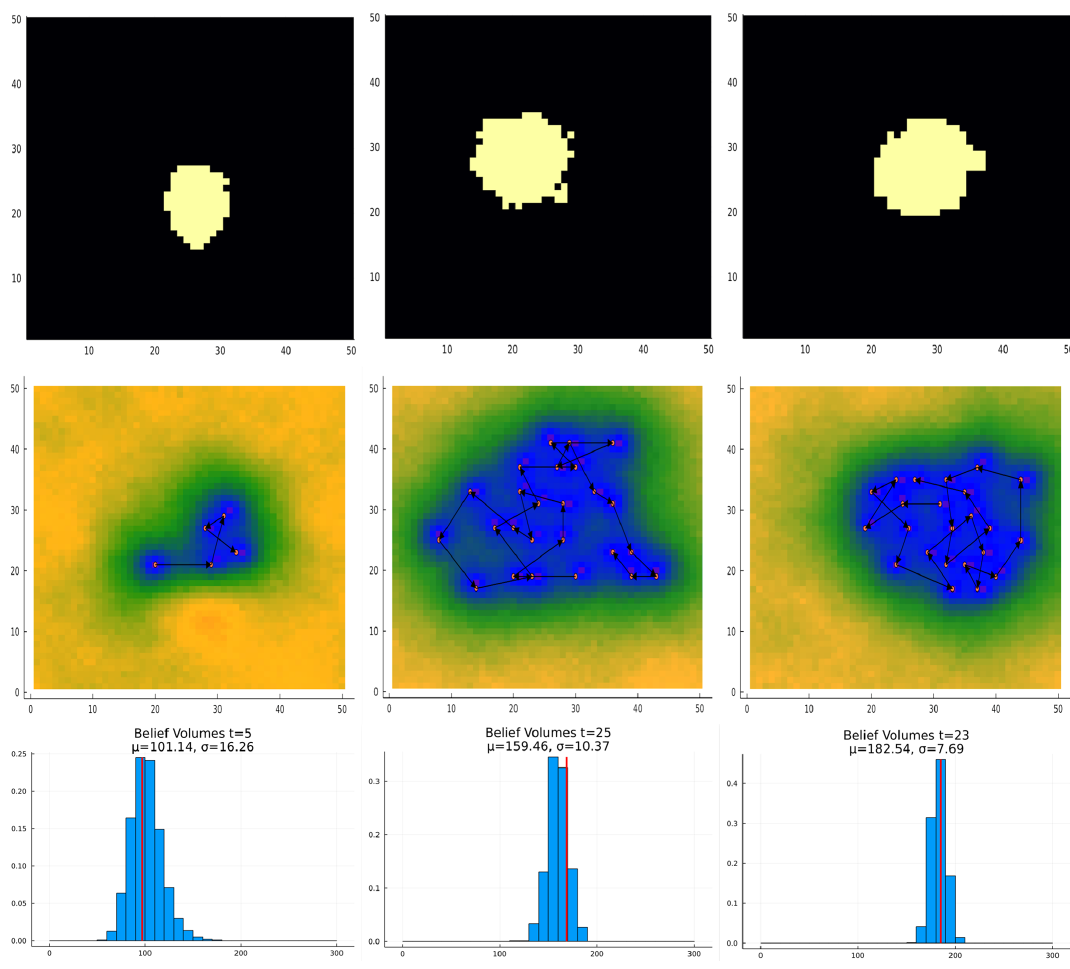
Figure 30. Deposit size study results for the case of a single body with variable centroid location. The sub-economic, borderline, and economic cases are shown in the left, center, and right columns, respectively. The top row shows the massive ore present in the tested case. The center row shows the trajectory taken by POMCPOW and the standard deviation of the resultant belief. The bottom row shows the histogram of the ore volumes in the final belief along with the true massive ore volume. Table 8. Deposit size study summary. The total number of measurements taken by POMCPOW before terminating the measurement cam- paign is shown for each test configuration and deposit size. Cases in which the maximum 25 measurements were taken are shown in